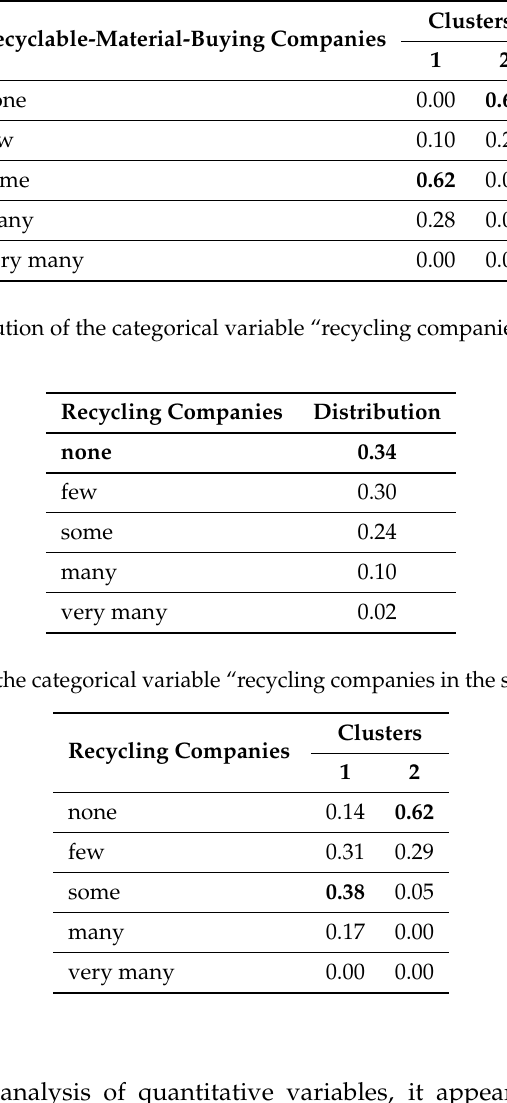
Table 14. Distribution of the categorical variable “recyclable-material-buying companies”.